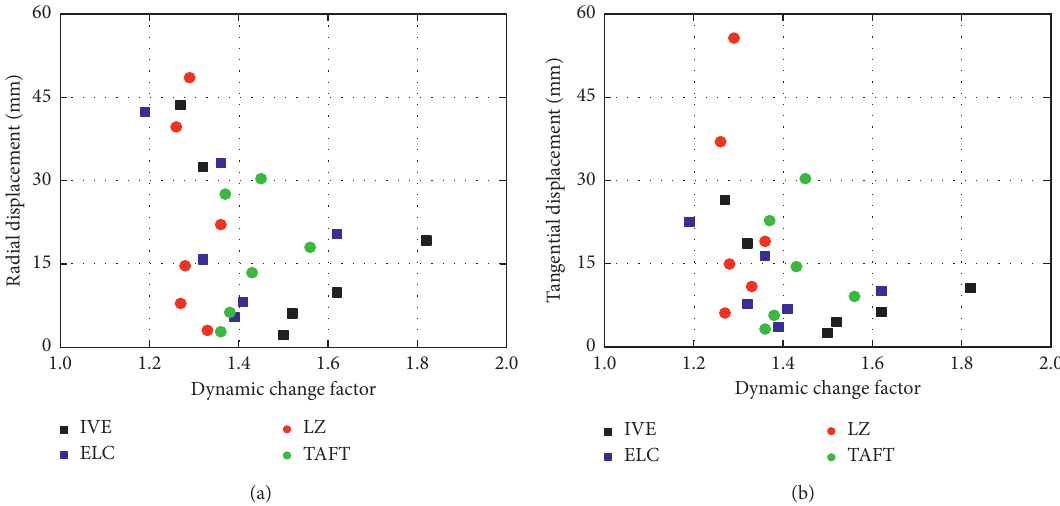
Figure 7: The relationship between displacement response and dynamic change factor of pier #3. (a) Radial. (b) Tangential.